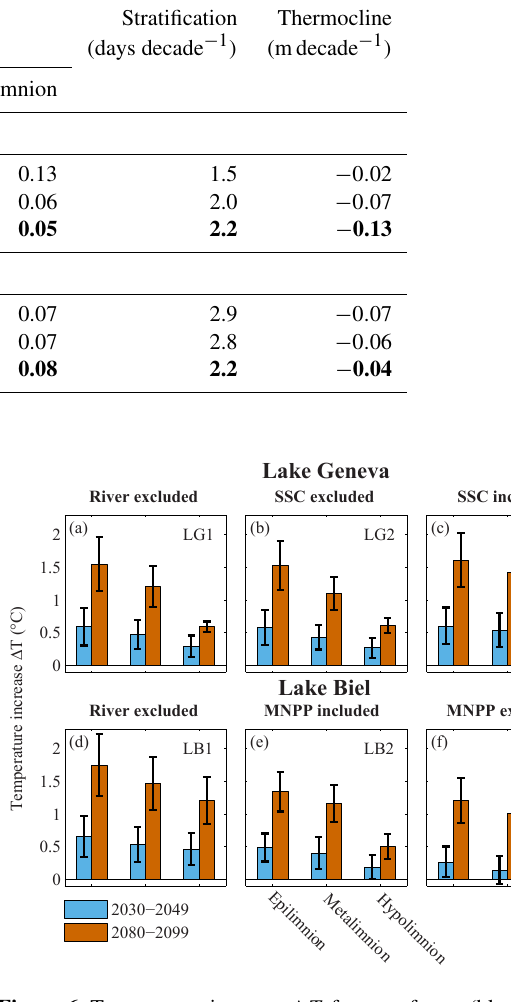
Figure 6. Temperature increase (cid:49)T for near-future (blue) and far- future (orange) time periods relative to reference period tempera- tures, displayed as mean (columns) and standard deviation (black bars) calculated from the nine basic model runs in the near-future and far-future scenarios. Epilimnion (left pair of columns), metal- imnion (middle pair) and hypolimnion (right pair) in LG ( a to c ) and LB ( d to f ). Graphs represent river intrusion excluded ( a and d ), river-borne SSC included ( c , e and f ) and excluded (b) . Mühleberg Nuclear Power Plant (MNPP) heat release included in (e) and ex- cluded in (f) from near-future and far-future time periods but re- tained for the reference